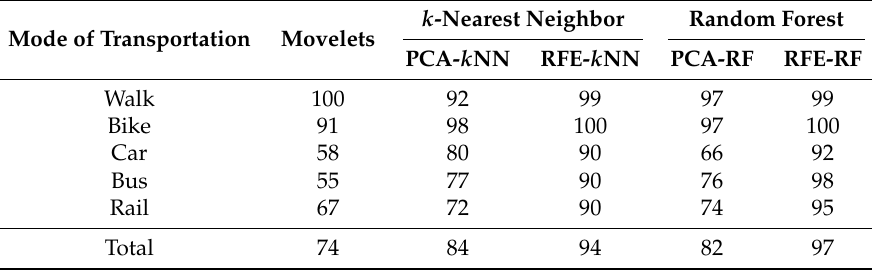
Table 1. Percent correctly predicted, by mode of transportation, using the optimal version of each